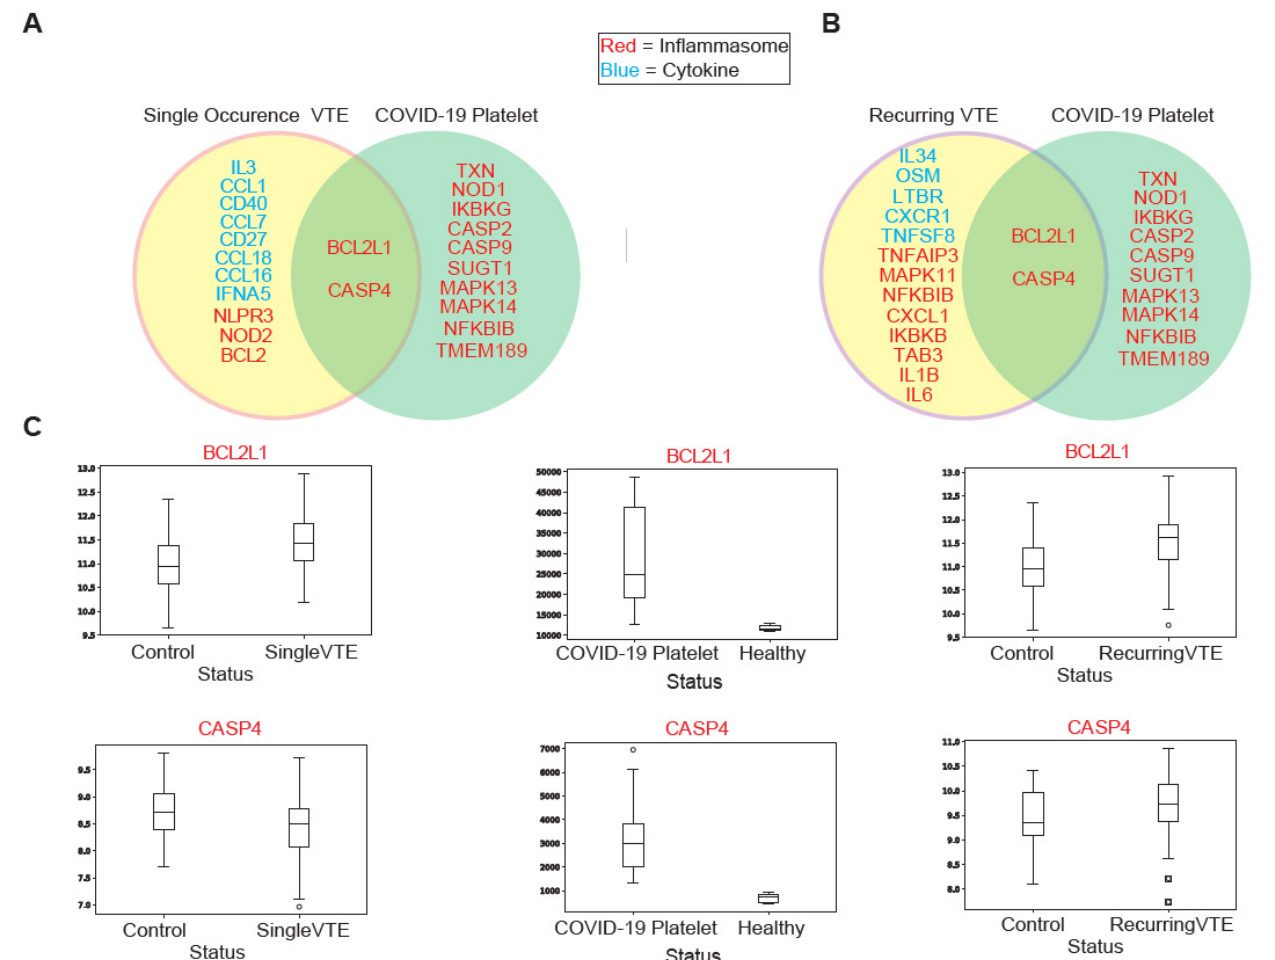
Figure 3. ( A ) Summary of common dysregulated genes correlated with pathways in single venous thromboembolism (VTE) and COVID-19. ( B ) Summary of common dysregulated genes correlated with pathways in recurring VTE and COVID-19. ( C ) Boxplots of CASP4 and BCL2L1 expression in COVID-19 and VTE cohorts.